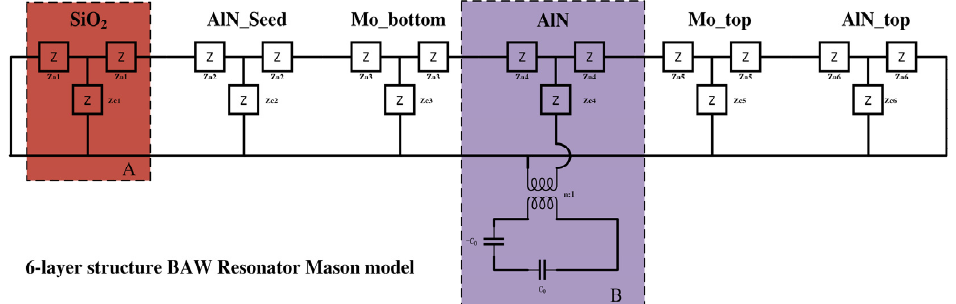
all involved layers.